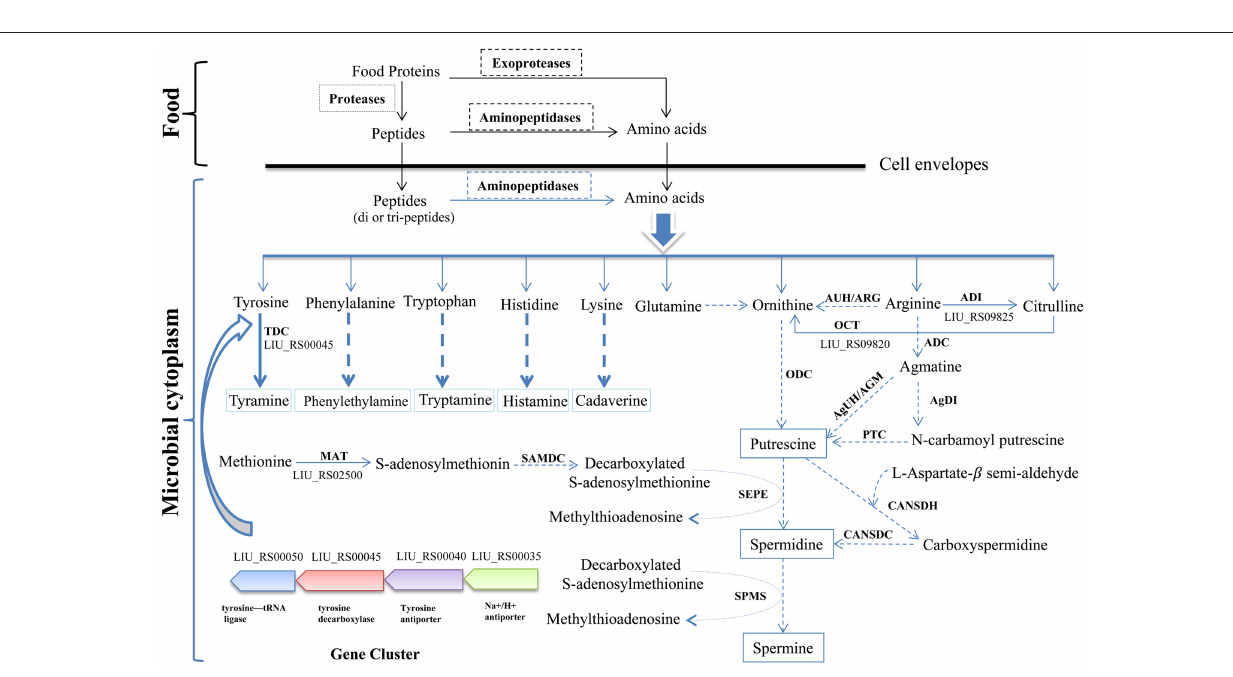
FIGURE 4 | Biosynthesis pathways of different biogenic amines by Enterococcus durans KLDS6.0930. Solid arrows represent that the biosynthesis pathways of biogenic amine is effective, correspondingly, the dashed arrows imply invalid; ODC, ornithine decarboxylase; ARG/AUH, arginase/arginine ureohydrolase; ADI, arginine deiminase; ADC, arginine decarboxylase; AgDI, agmatine deiminase; PTC, putrescine transcarbamoylase; AGM/AgUH, agmatinase/agmatine ureohydrolase; OCT, Ornithine carbamoyl transferase; CANSDH, carboxynorspermidine dehydrogenase; CANSDC, carboxynorspermidine decarboxylase; MAT, methionine adenosyl transferase; SAMDC, S-adenosylmethionine decarboxylase; SEPE, spermidine synthase; SPMS, spermine synthase; TDC, tyramine